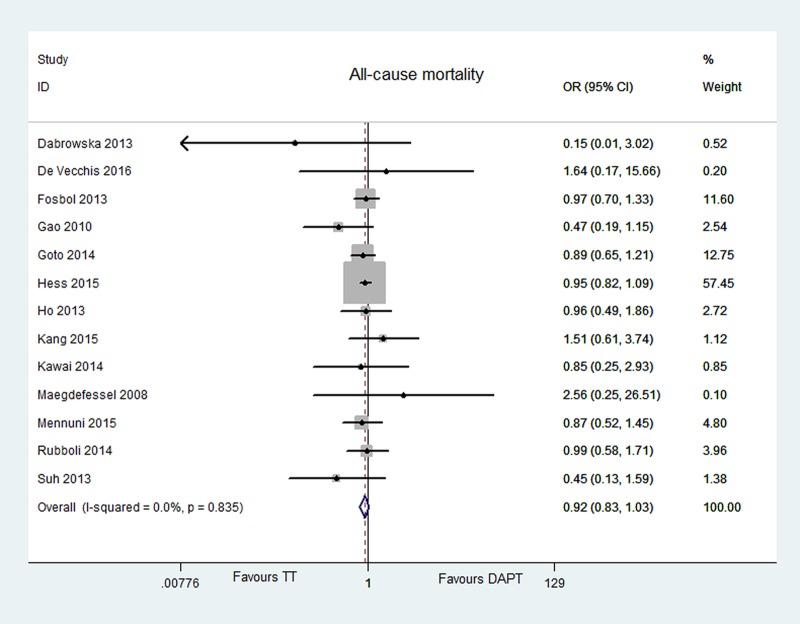
Forest plot of all-cause mortality in TT group vs DAPT group.